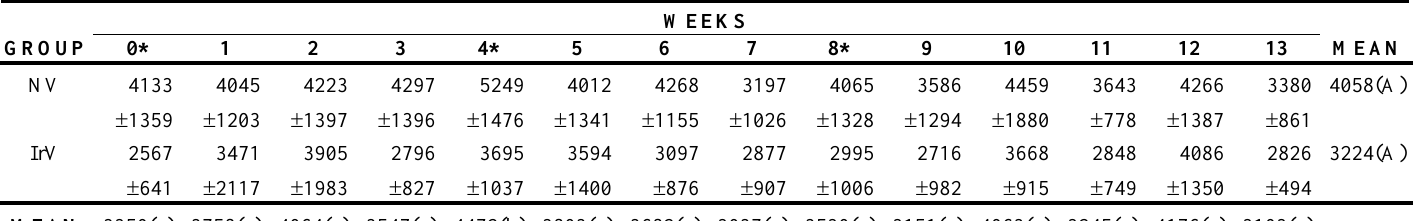
Difference between groups: F=2.77; p>0.05, GI=GII. Difference between times: F= 3,11; p<0,05. Interaction: F= 0.87; p>0.10 Different capital letters show significant statistical differences between groups. Different lowercase letters show significant statistical differences between